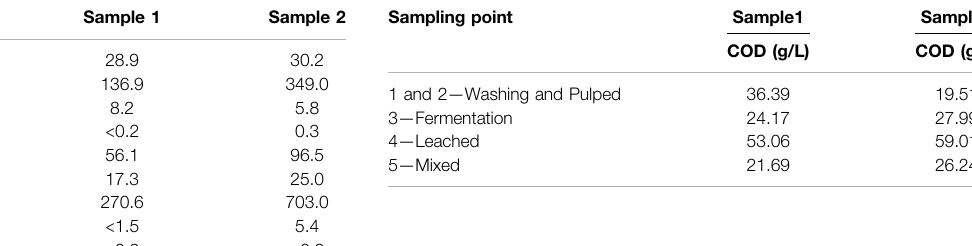
TABLE 1 | Chemical characterization of coffee wet processing wastewater from Sampling point 5. Analysis